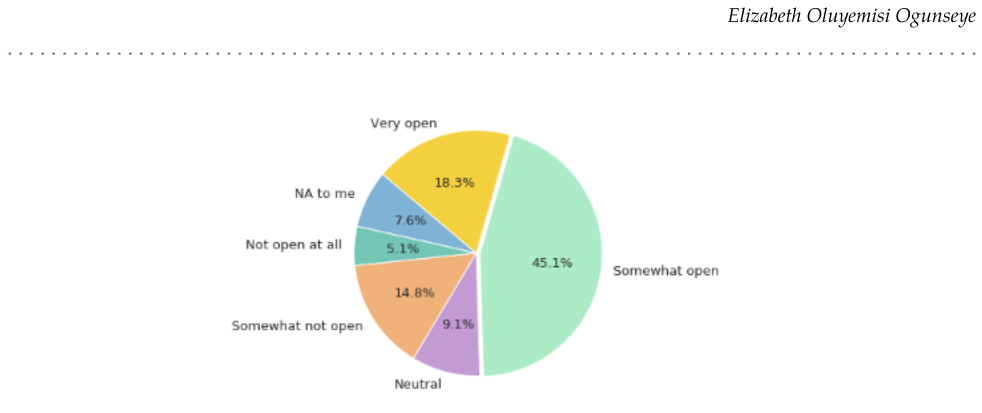
Figure 10: Being open about Mental Health with friends and family